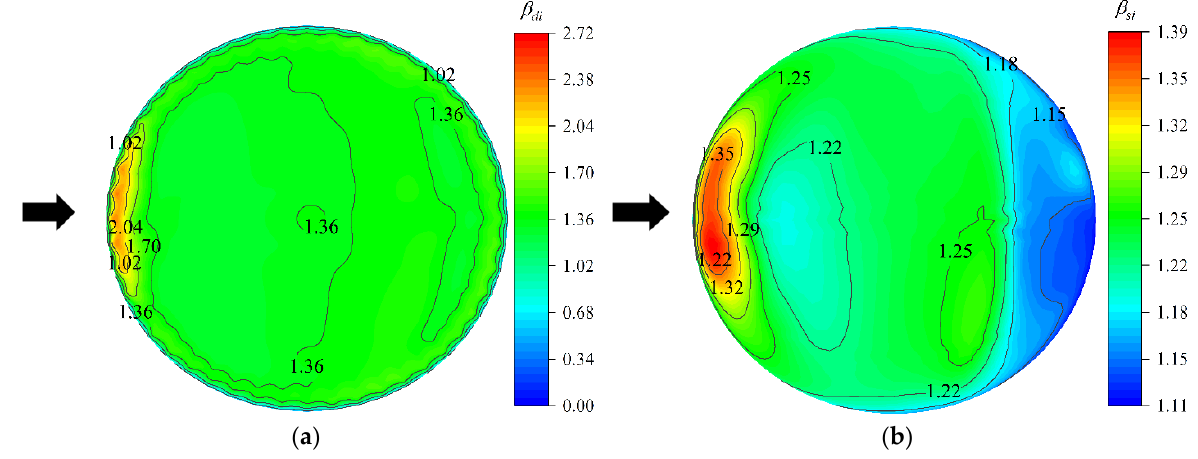
Figure 21. Contours of gust response factors: ( a ) Displacement ‐ based; ( b ) Stress ‐ based.